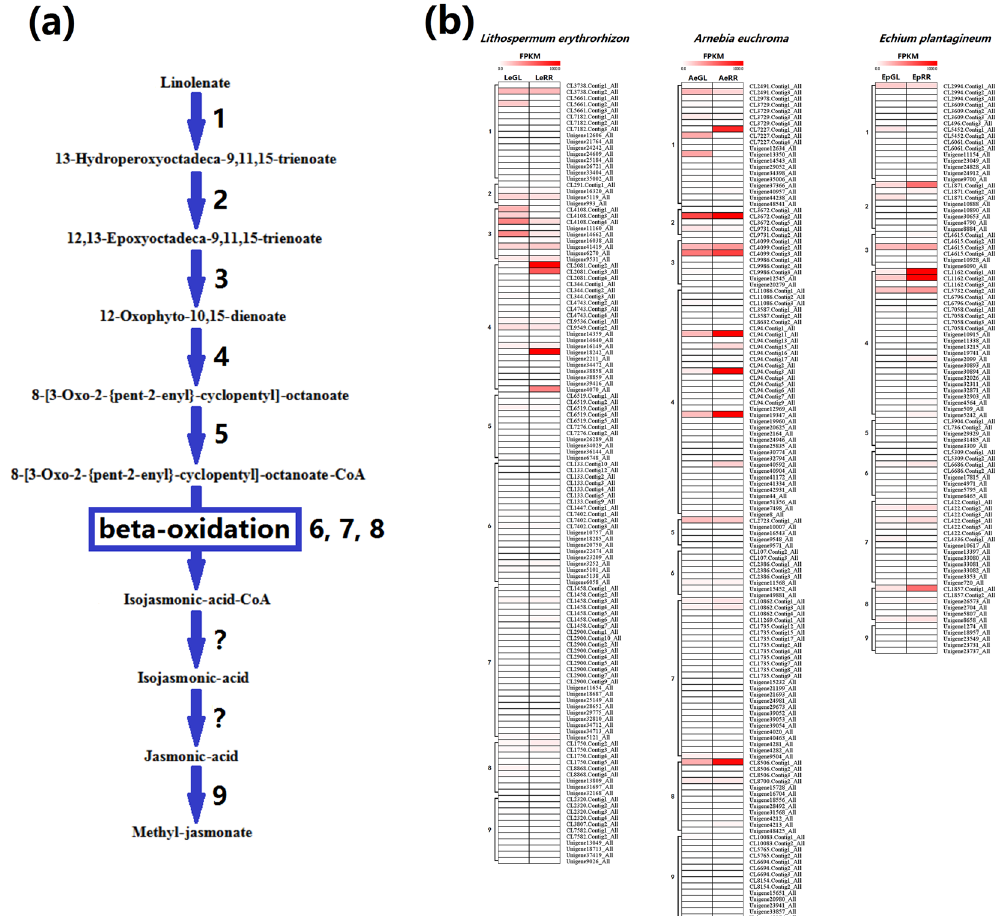
Figure 5. Unigene expression involved in methyl jasmonate biosynthesis in Lithospermum erythrorhizon , Arnebia euchroma and Echium plantagineum . ( a ) Methyl jasmonate biosynthesis, ( b ) Unigene expression involved in methyl jasmonate biosynthesis? One step unknown; 1. Lipoxygenase gene ( LOX ), 2. Allene oxide synthase gene ( AOS ), 3. Allene oxide cyclase gene ( AOC ), 4. 12-Oxophytodienoate reductase gene ( 12OPR ), 5. CoA ligase gene ( CL ), 6. Acyl-CoA oxidase gene ( ACX ), 7. Fatty acid β -oxidation multifunctional protein MFP/ AIM gene ( MFP/AIM ), 8. 3-ketoacyl-CoA thiolase gene ( KAT ), 9. Jasmonate O-methyltransferase gene ( JMT